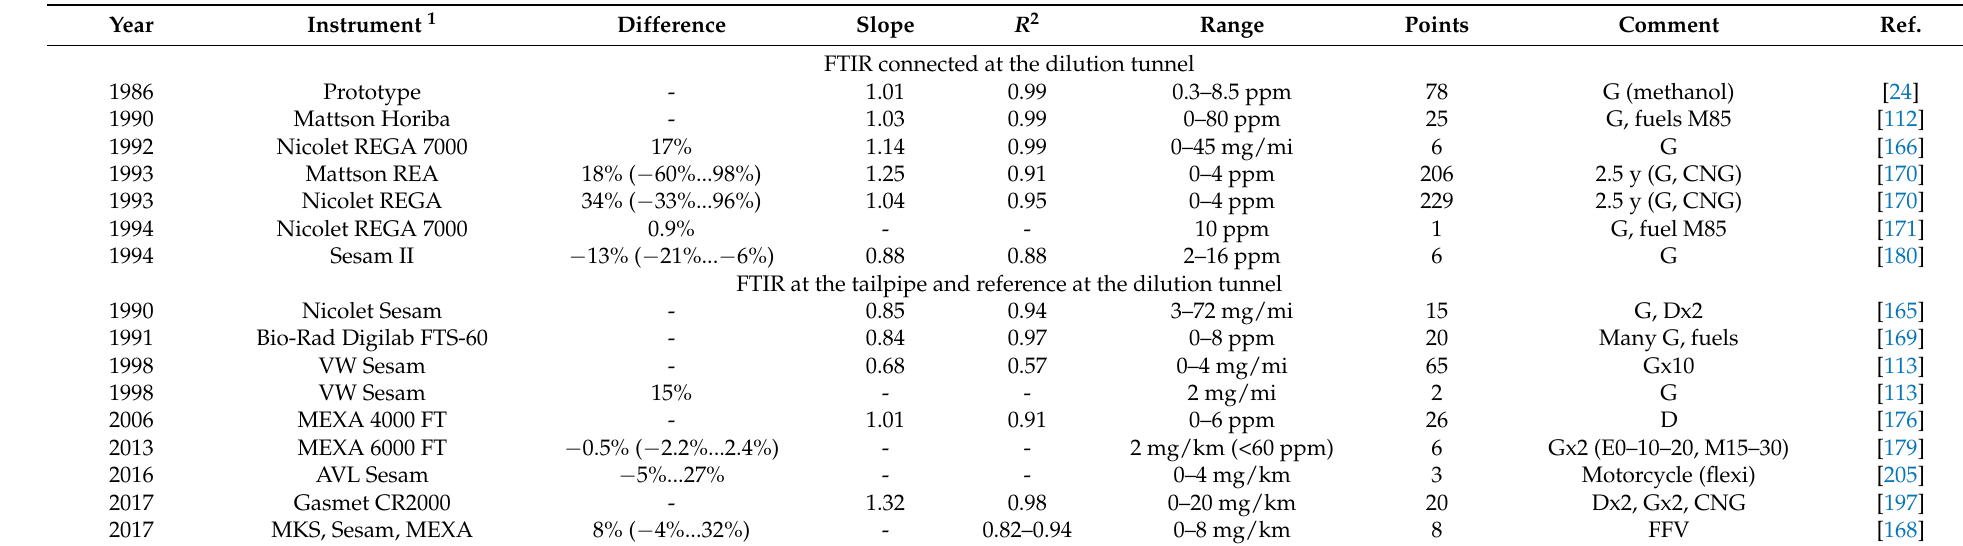
Table A8. Comparisons of FTIR with formaldehyde (CH 2 O) methodology (DNPH + HPLC).